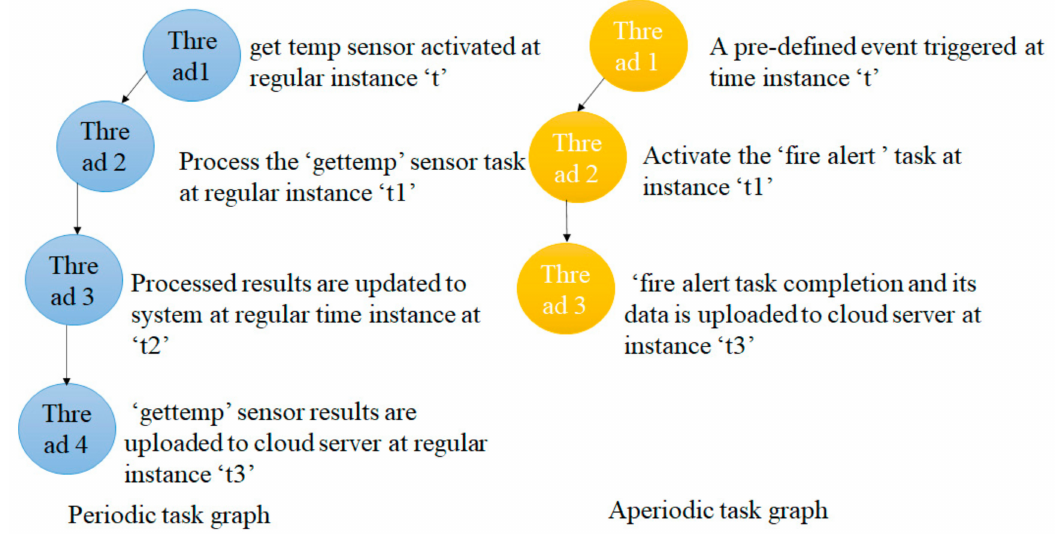
Figure 2. ( left ) Periodic workload “getemp” sensor processing task is represented with subtasks, ( right ). Aperiodic workload “fire alarm” task with its